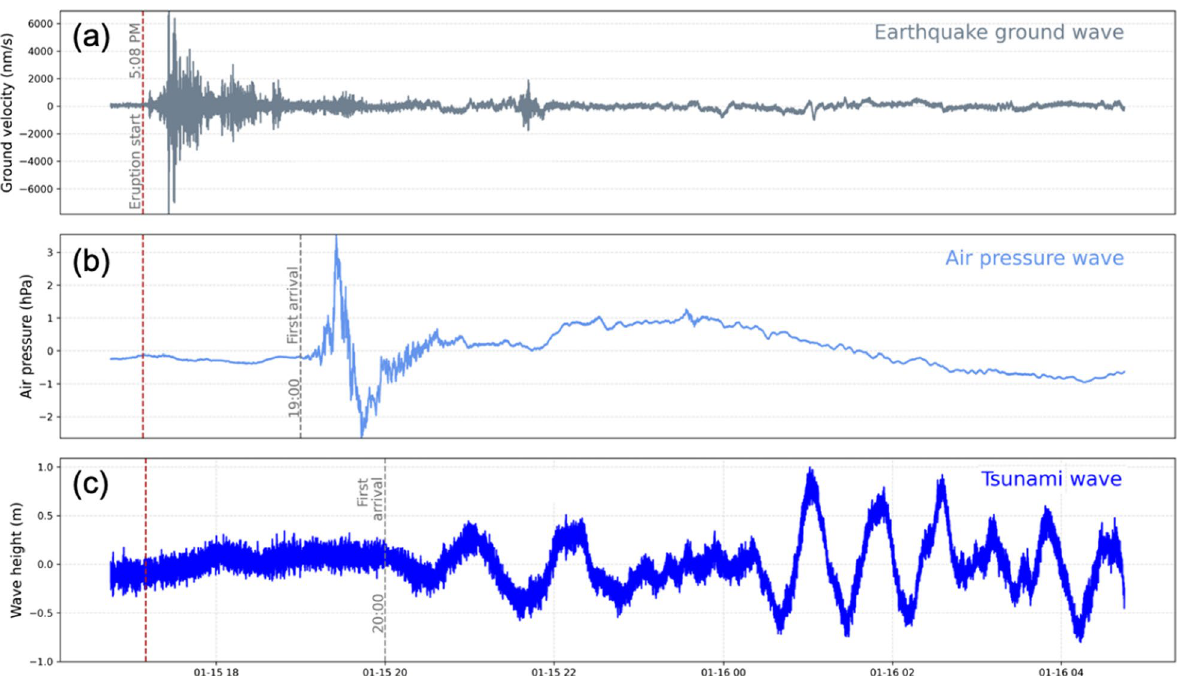
Fig. 8 The graphs show a the earthquake ground wave, b the air pressure wave, and c the tsunami wave following the volcanic